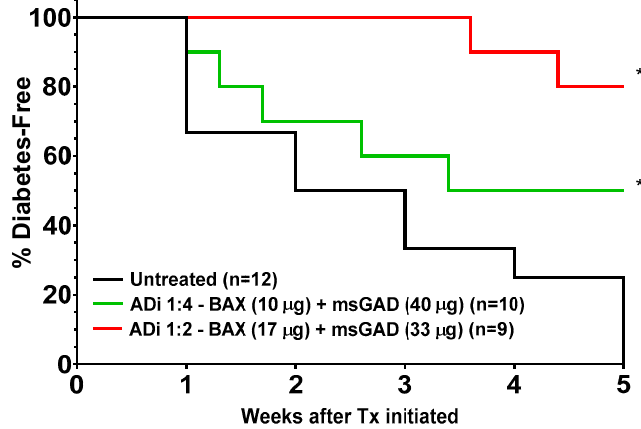
Figure 3. Increased efficacy of ADi-100 containing greater BAX plasmid content when administered to highly hyperglycemic NOD mice. Groups of female NOD mice were monitored weekly for morning blood glucose (mBG) levels, in which each mouse received the first ADi-100 dose (day 0) of an i.d. injection of either of two ADi-100 formulations, 1:4 or 1:2, when mBG was ≥ 180 mg/dL on at least two occasions or upon the first occurrence of mBG ≥ 200 mg/dL. On day 0, the mean ± SEM mBG of all 31 mice was 244 ± 12 mg/dL. Mice received weekly ADi-100 injections thereafter for a total of five injections. Daily mBG monitoring continued and mice were diagnosed with diabetes when ≥ 300 mg/dL on two occasions at least seven days apart. The percentage of mice that remained free of diabetes in each cohort are presented. * p < 0.035 for ADi-100 1:4 and p < 0.001 for ADi-100 1:2 compared to untreated cohort.